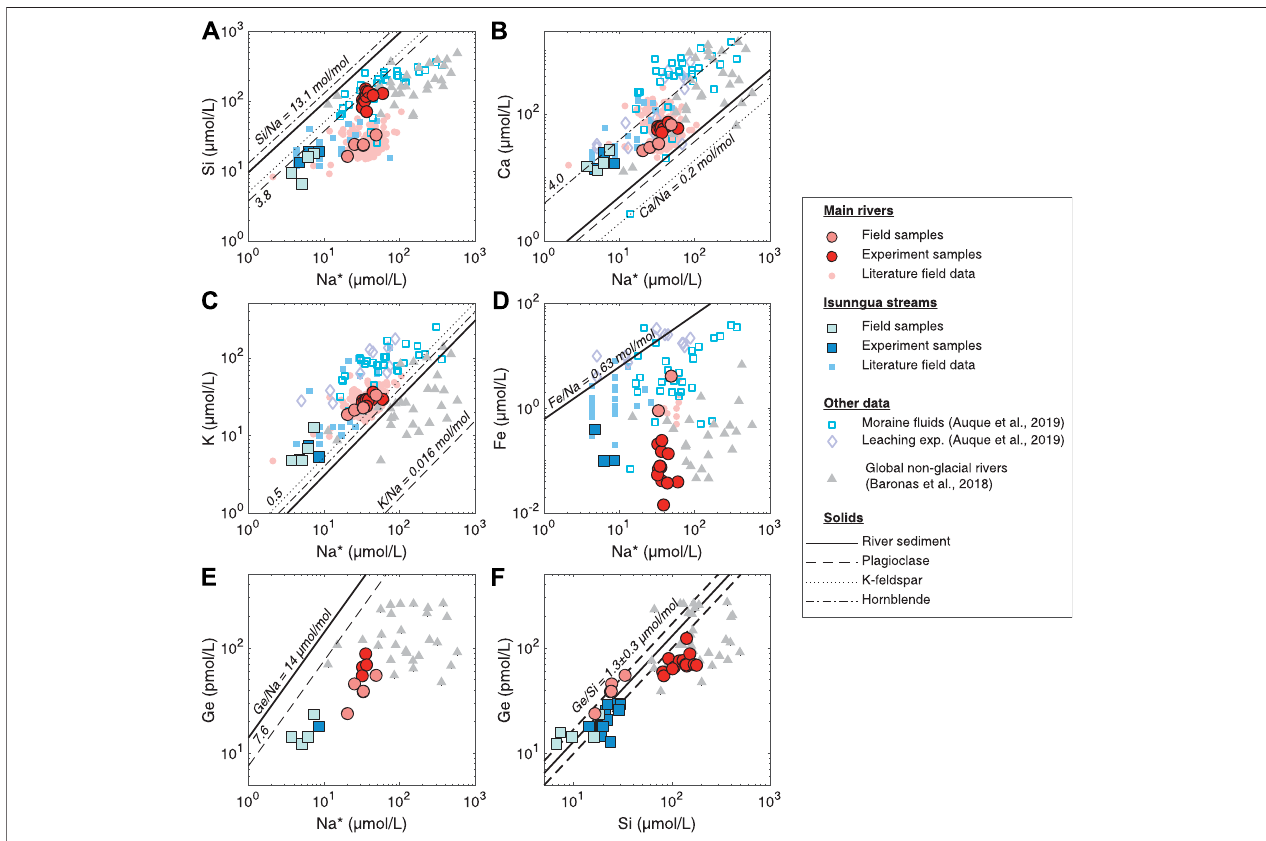
FIGURE 4 | Solute signatures of streams and dominant bedload minerals in southwest Greenland compared to experimental solutions and global rivers. Main (Akuliarusiarsuup Kuua, Qinnguata Kuussua, and Watson) river and Isunngua stream literature data from Wimpenny et al. (2010); Hindshaw et al. (2014); Andrews et al. (2018);AndrewsandJacobson(2018);Deuerlingetal.(2019);Hattonetal.(2019a).RiversedimentandindividualmineralcompositionsfromWimpennyetal.(2010)and Hindshaw et al. (2014),respectively. Na* refers toNa concentrations corrected for cyclic salt inputs (Na* (cid:1) Na – 0.85 · Cl). The solid and dashed lines in (F) show the Ge/Siand2S.D.uncertainty, respectively,oftheWatsonRiversuspendedsediment,calculatedfromGeconcentrationmeasured inthisstudyandpreviouslymeasured Si concentrations ( Table 1